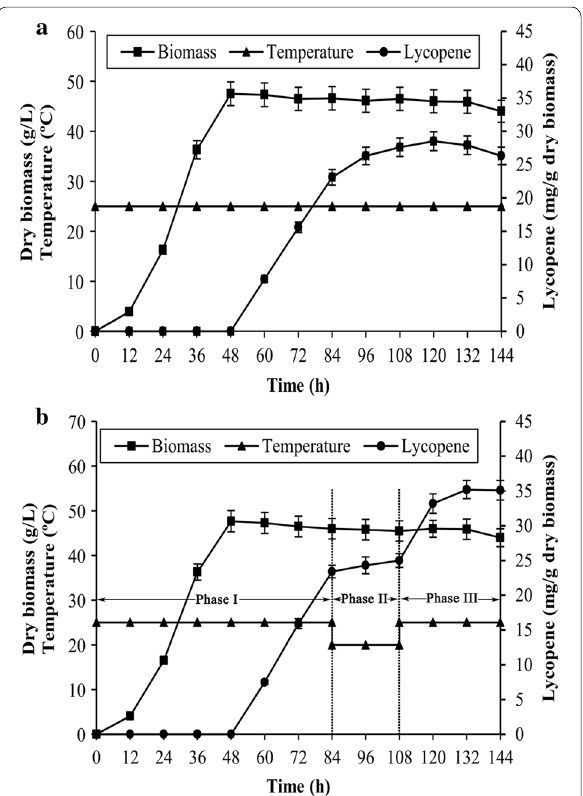
Fig. 4 Time course of lycopene concentration and dry biomass by B. trispora under a constant temperature and b varying temperature. Error bars indicate SEs of mean values. Solid square, dry biomass; solid triangle, temperature; solid circles, lycopene concentration